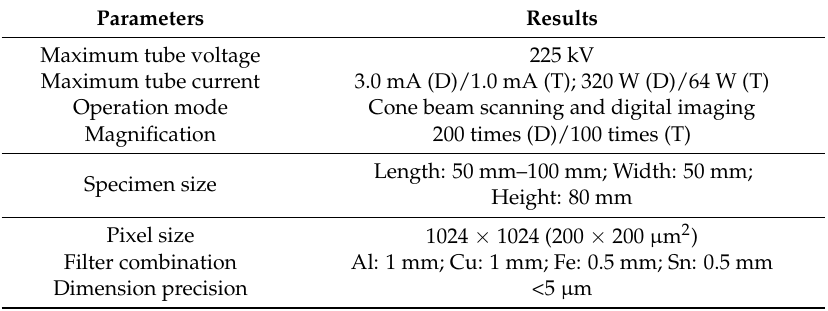
Table 8. The parameters of industrial X-ray computed tomography (X-ray CT).